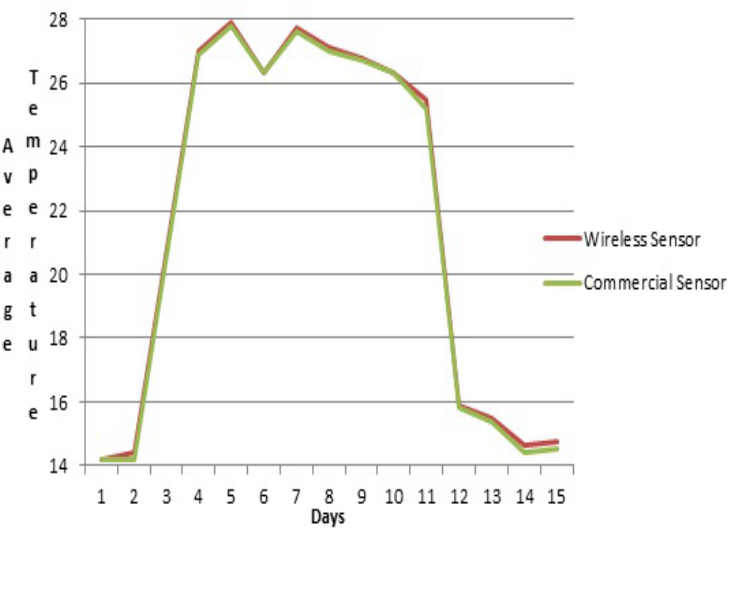
Figure 14. Average temperature value register: HI 98509-01 vs.